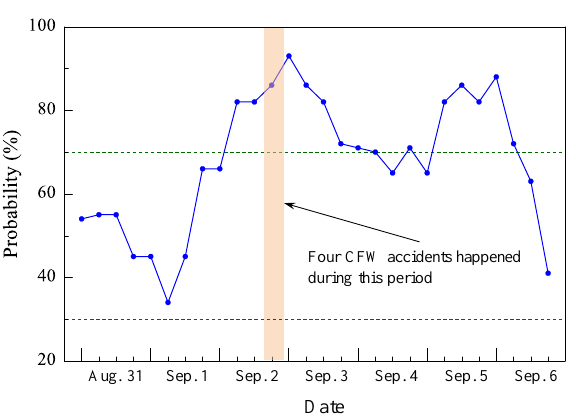
Figure 6. Probabilistic CFW forecasting during the period of Typhoon Jebi.